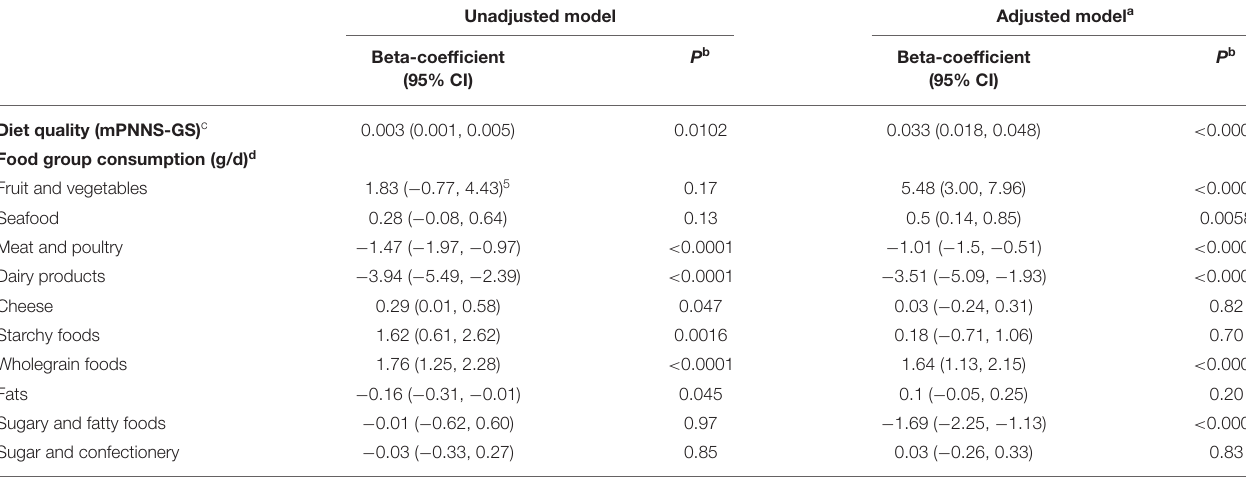
TABLE 4 | Associations between mastery (PMS), diet quality and consumption of food groups normally distributed (NutriNet-Santé cohort study,